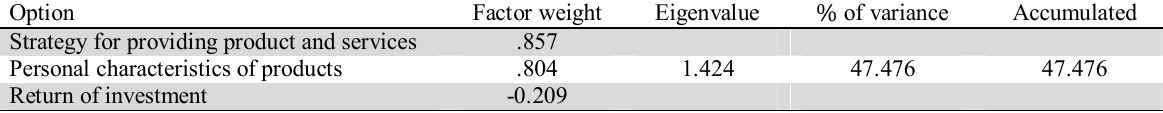
Option Factor weight Eigenvalue % of variance Accumulated Strategy for providing product and